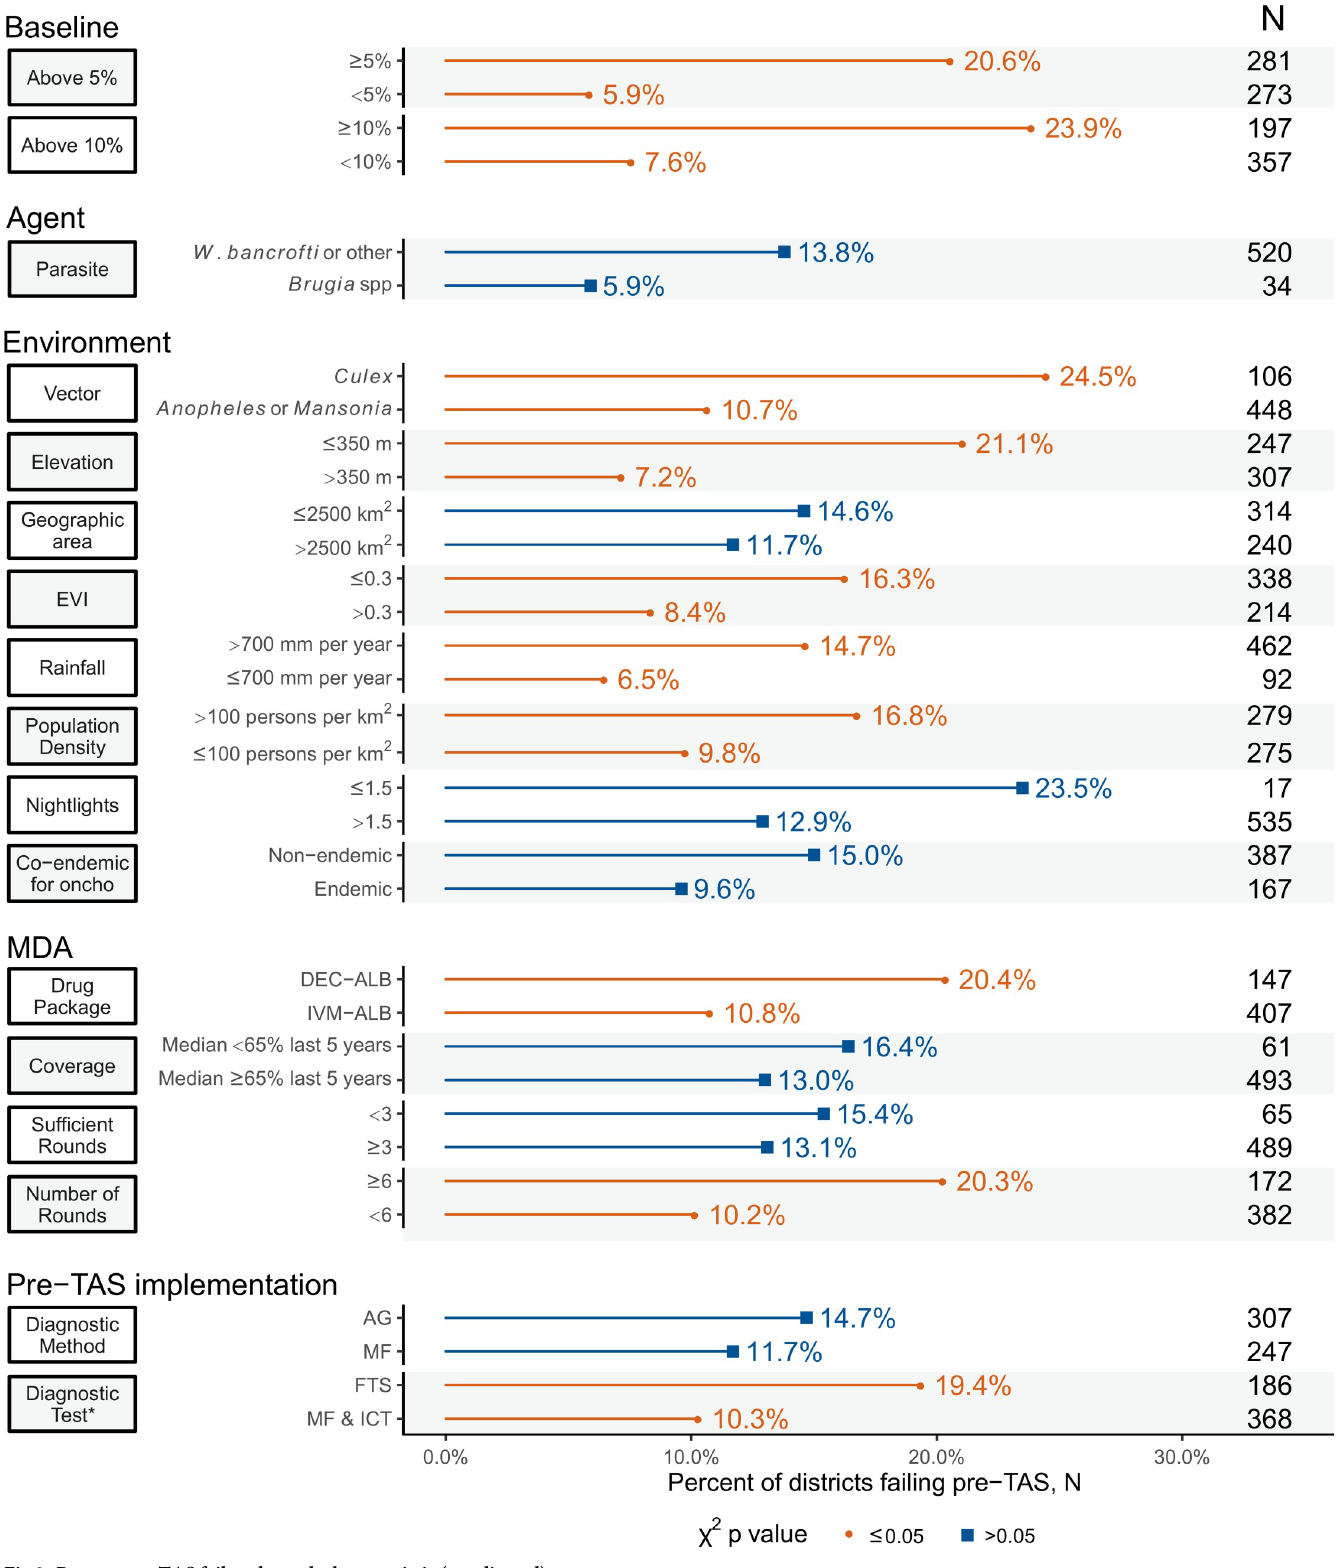
PLOS NeglectedTropical Diseases | https://doi.org/10.1371/journal.pntd.0008301 June 1,